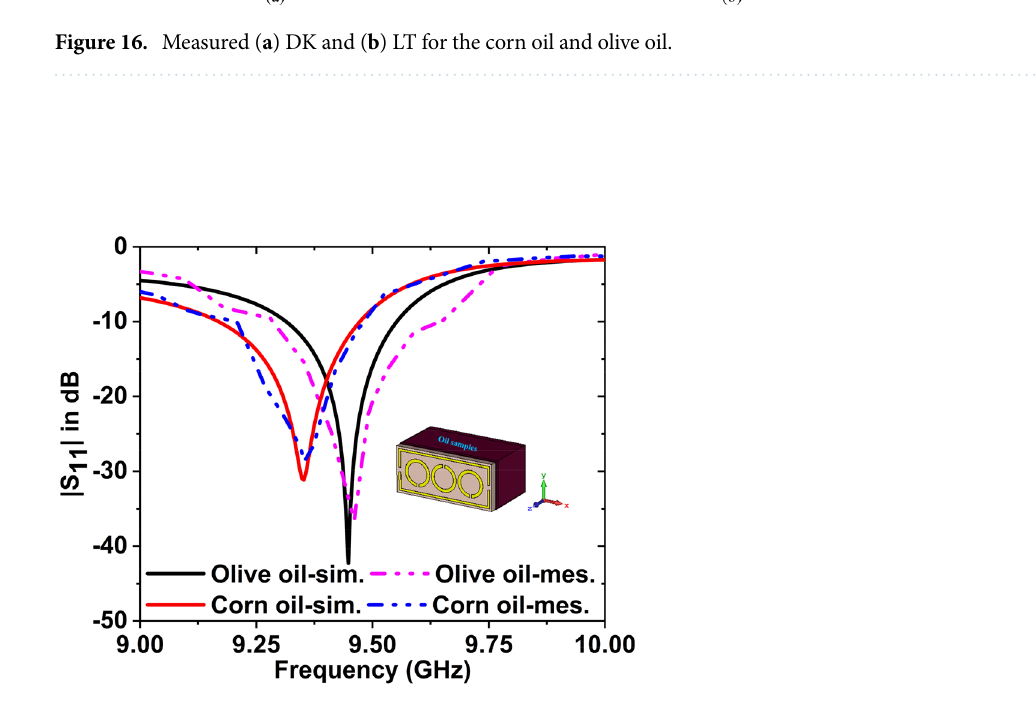
Figure 17. S 11 results for the corn oil and olive